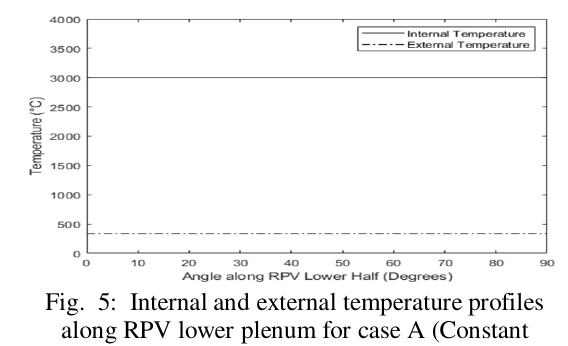
Fig. 5: Internal and external temperature profiles along RPV lower plenum for case A (Constant temperature source)